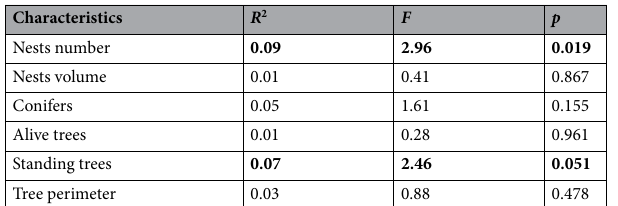
Table 2. The effect of the number and size of red wood ant nests and tree characteristics (proportion of conifers, alive trees, standing trees and tree perimeter) on the dissimilarities in the number of trees infected by wood boring beetles and fungi. The results are based on the PERMutational ANOVA. *Significant results are with bold font.